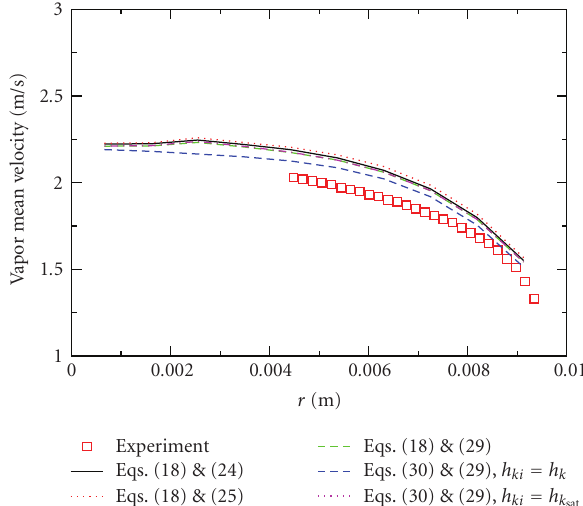
Figure 2: comparison of the di ff erent models on the vapor velocity